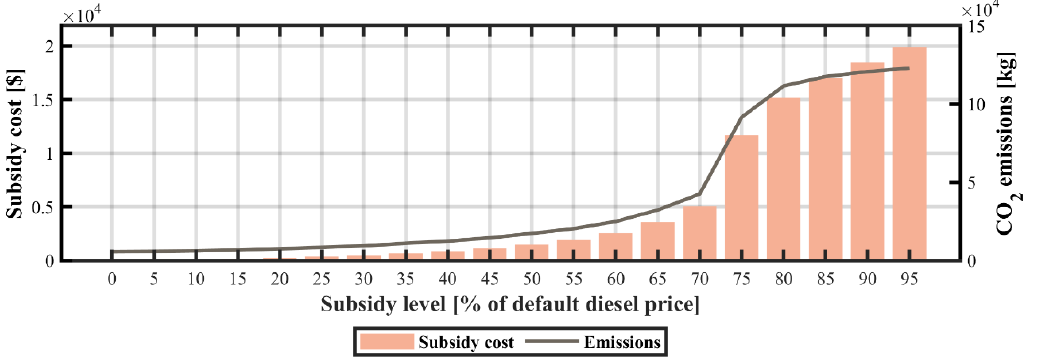
Figure 19. Simulation results of diesel fuel subsidies. Impact on subsidy costs and CO 2 emission levels.